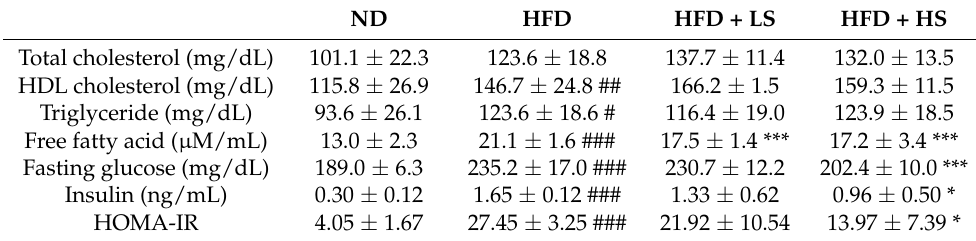
Table 2. Serum parameters in mice fed the experimental diet for 15